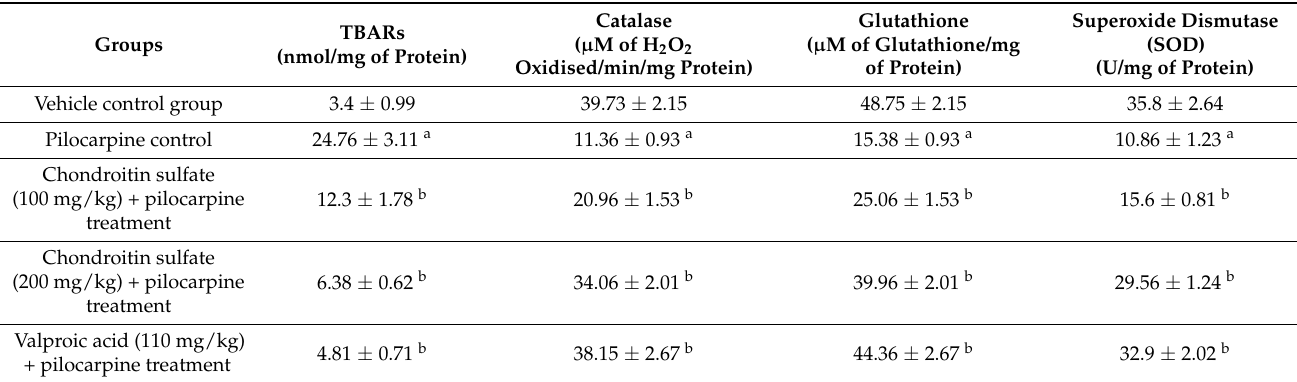
Table 2. Antiepileptic effect of CS on biochemical estimation parameters in pilocarpine induced-spontaneous recurrent seizures. Values are expressed as mean ± S.D.; a p < 0.01 vs. vehicle control; b p < 0.05 vs. PC